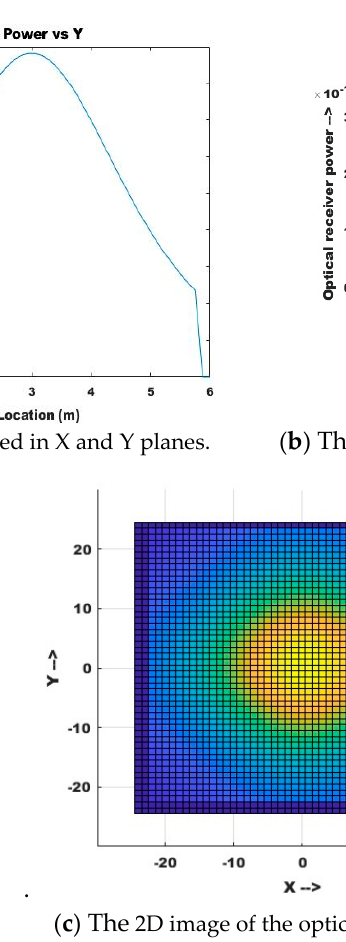
Figure 1. Distribution of received power in each plane.